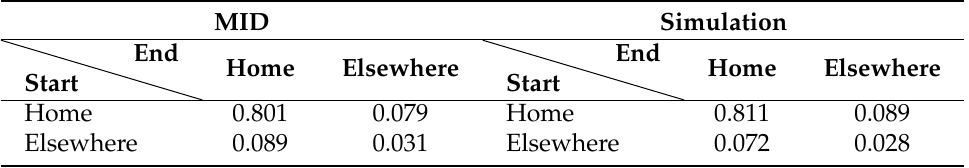
Table 2. Share of cars returning to and starting from home at the end of a day when comparing MID and the